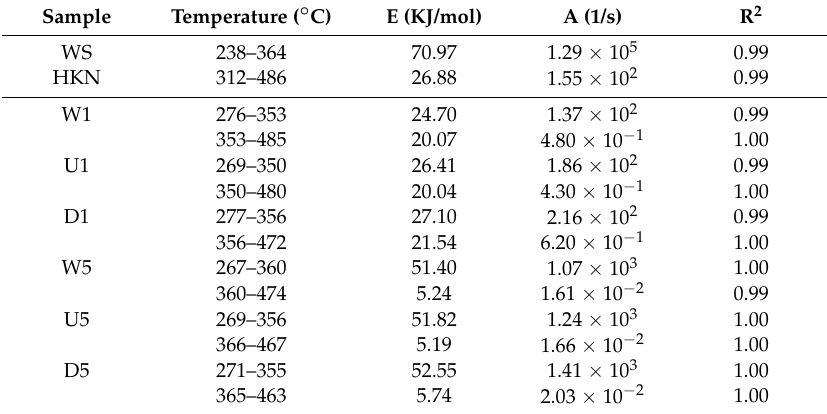
Table 3. Kinetics parameters for pyrolysis of single and blend samples under different contact